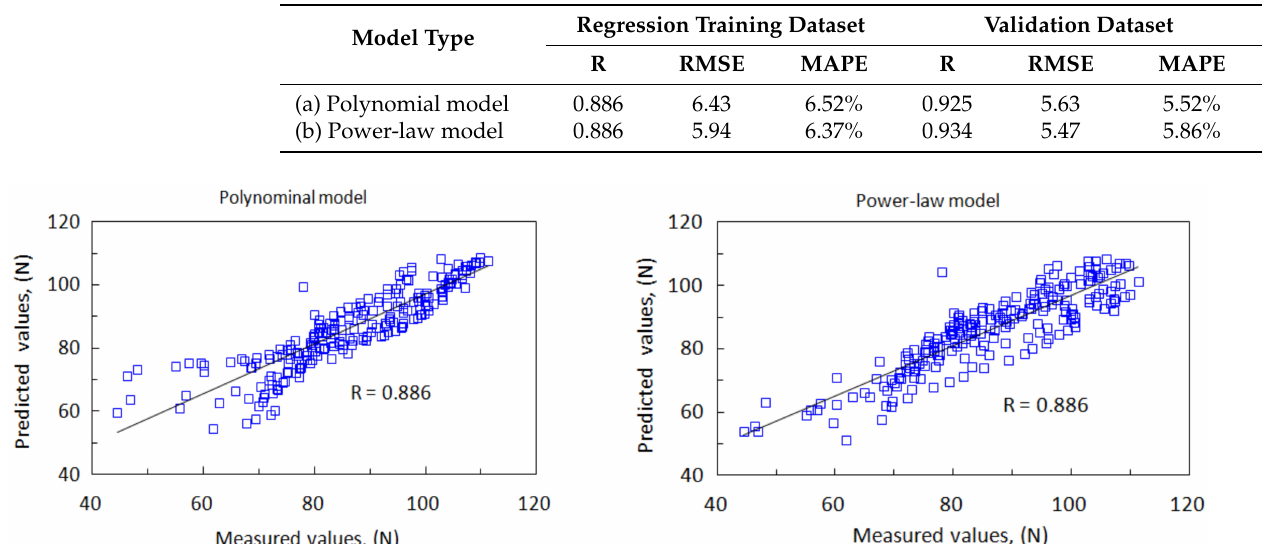
Figure 13. Comparisons of the cutting force between measurements and